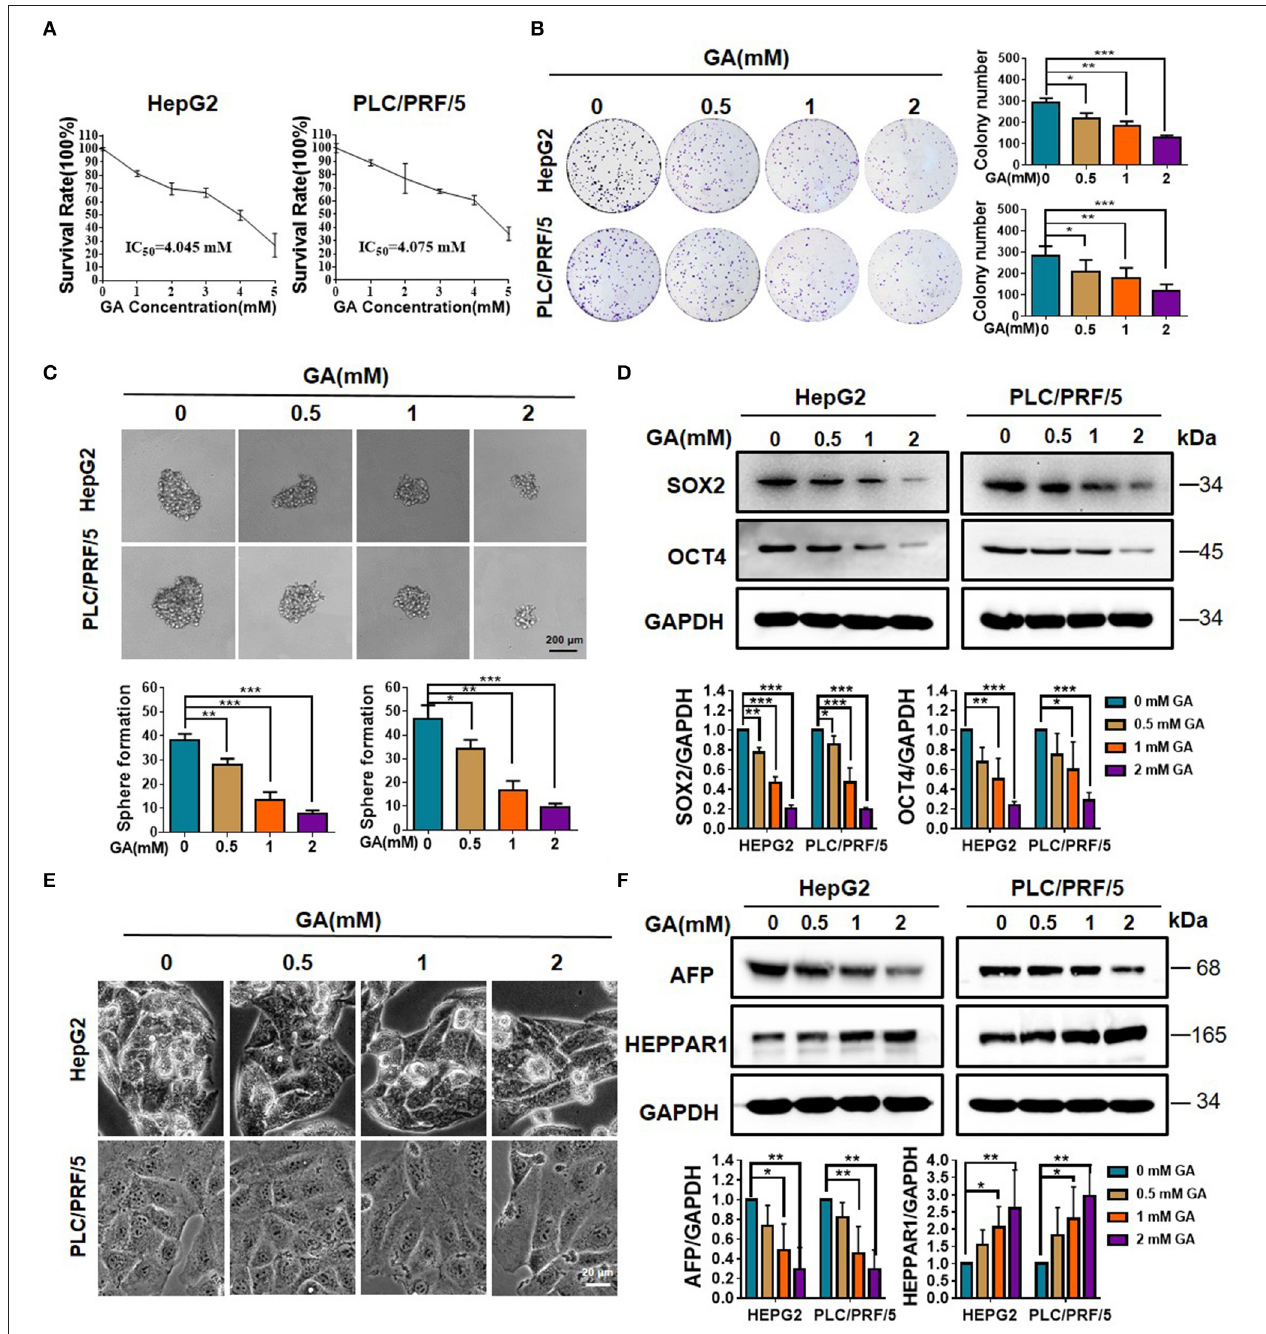
FIGURE 1 | GA reduces stemness and induces differentiation of hepatic cancer cells. (A) Survival of HepG2 and PLC/PRF/5 cells incubated with the indicated amounts of GA for 48h. (B) Cell proliferation was assessed through a colony formation assay. The number of colonies was compared (one-way ANOVA; * P < 0.05, ** P < 0.01, *** P < 0.001). (C) Images of sphere formation assay of HepG2 and PLC/PRF/5. The number of spheres was compared (one-way ANOVA; * P < 0.05, ** P < 0.01, *** P < 0.001). (D) Expression of representative CSC markers (SOX2 and OCT4) was analyzed by Western blot assay (one-way ANOVA; * P < 0.05, ** P < 0.01, *** P < 0.001). (E) Images of HepG2 and PLC/PRF/5 cells were taken after incubation with different GA concentrations. (F) Expressions of representative differentiation markers (AFP and HEPPAR1) were analyzed by Western blot assay (one-way ANOVA; * P < 0.05, ** P < 0.01). Scale bars in C and E are at 200 and 20 µ m,